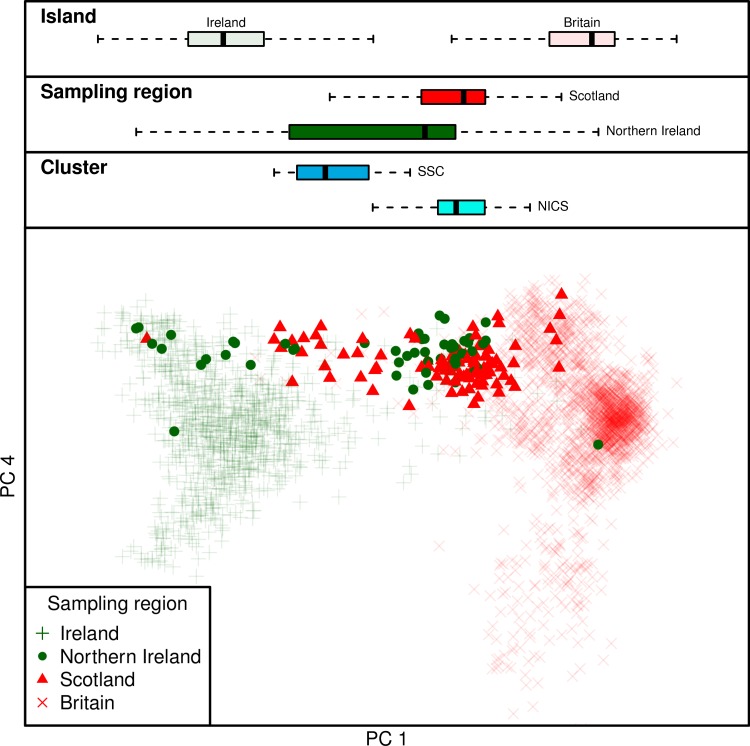
Inter-island exchange of haplotypes between the north of Ireland and northern Britain.The boxplots show the distribution of individuals on principal component (PC) 1 for each island and for specific sampling regions (Scotland/Northern Ireland) and cluster groups (SSC and NICS; see Fig 2). A substantial proportion of Northern Irish individuals fall within the expected range for Scottish individuals in PC space and vice versa. This exchange is particularly pronounced for Northern Irish and Scottish individuals that fall within the NICS and SSC cluster groups (Fig 2), respectively.